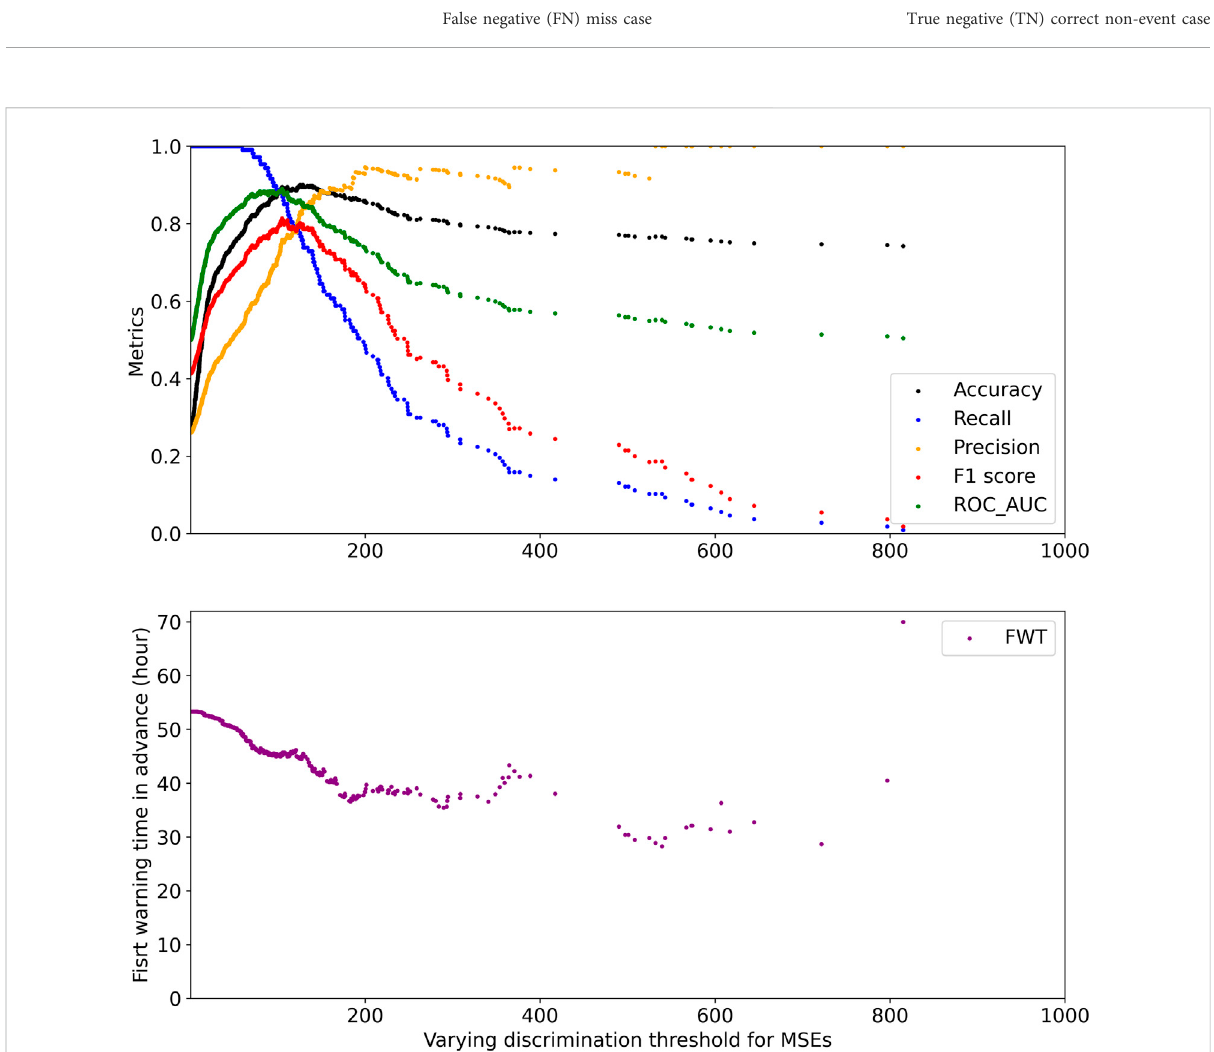
FIGURE 6 Evaluation metrics based on the group test with varying discrimination thresholds (set for MSEs of the original and reconstructed pictures). The accuracy, recall, precision, F1 score, ROC _ AUC , and fi rst warning time for strong fl ares in advance (FWT) are represented by the black, blue, orange, red, green, and purple points,